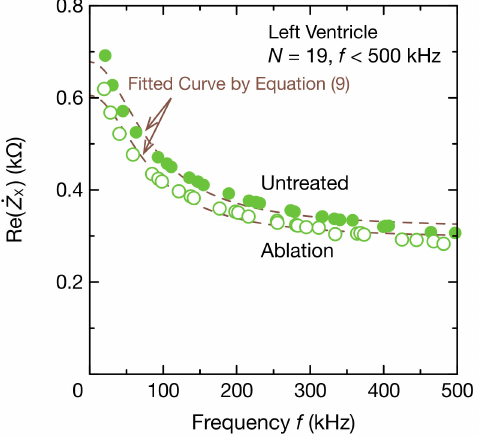
(cid:16) . (cid:17) . Z X Z X of the porcine my- of the impedance